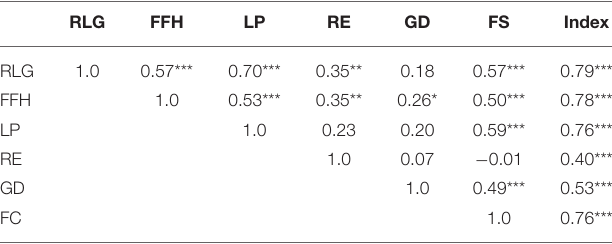
TABLE 8 | Spearman rank correlation coefficients between criteria selected in step one for calculating the habitat index [Red List status Germany (RLG), “Fauna-Flora-Habitat” (FFH), legal protection status (LP), regenerability (RE), Groundwater dependence (GD), floodplain specific habitats (FS), and habitat provision index